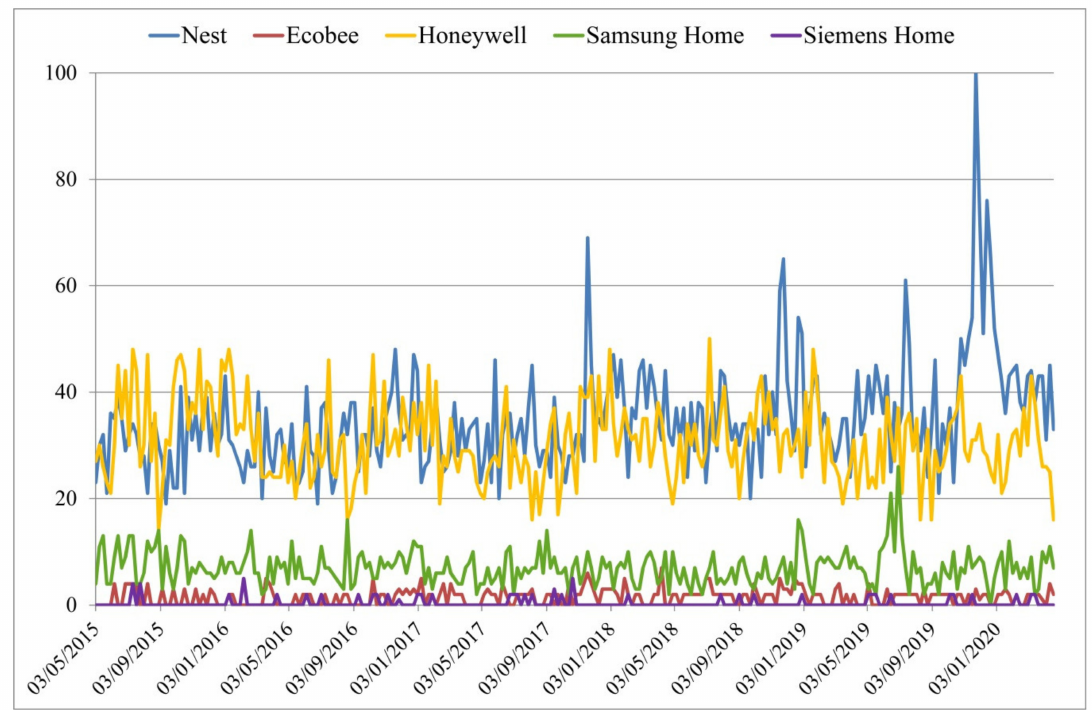
Figure 2. Trends in Google Shopping of the queries “Nest”, “Honeywell”, “Ecobee”, “Samsung home” and “Siemens home”. From Google